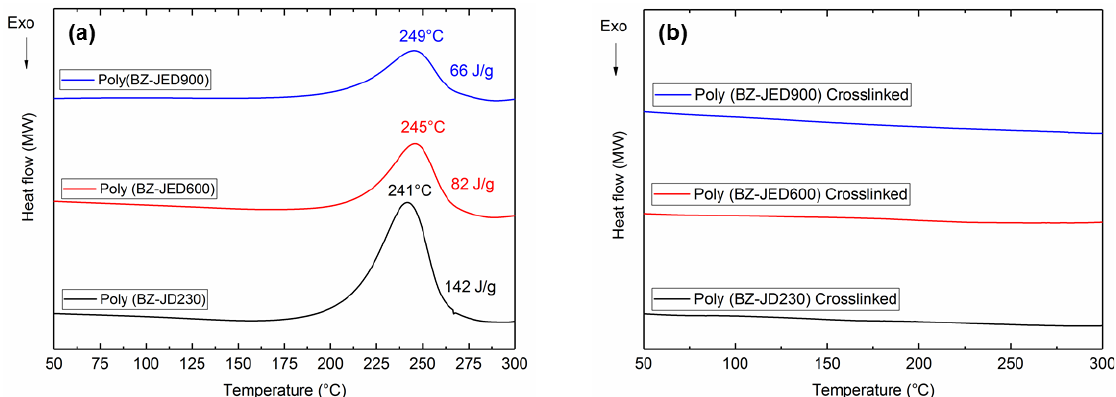
Figure 2. DSC thermograms (second heating cycle) of ( a ) uncrosslinked and ( b ) crosslinked PEG-based polybenzoxazine.